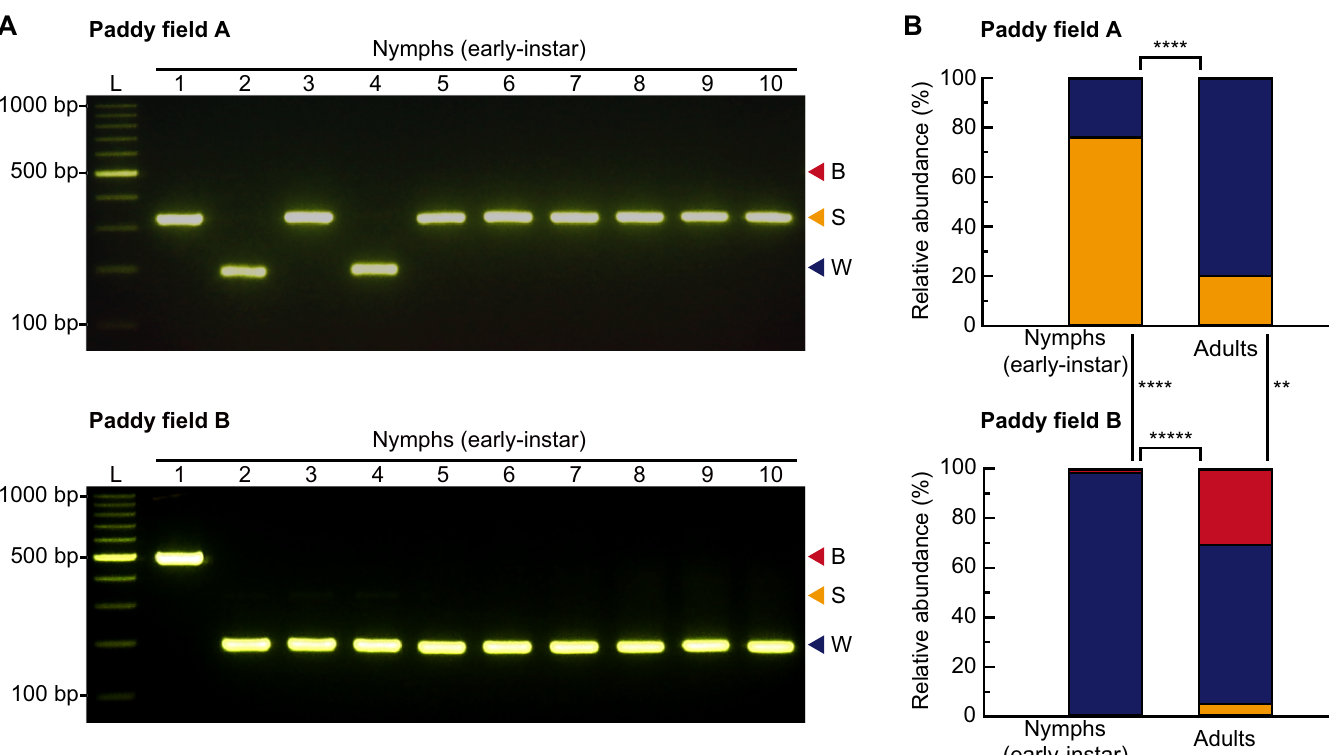
Fig 3. Quantification of rice planthopper species in paddy fields approximately one month after rice-planting. (A) Example gel electrophoresis results of multiplex PCR assays of individual early-instar nymphs from paddy fields A (top) and B (bottom). L, 100 bp DNA ladder; B, Nilaparvata lugens ; S, Laodelphax striatellus ; W, Sogatella furcifera . (B) Species composition of early-instar nymph and adult rice planthoppers ( N . lugens [red bars], S . furcifera [blue bars], and L . striatellus [yellow bars]) in paddy fields A (early-instar nymphs, n = 54; adults, n = 20) (top) and B (early-instar nymphs, n = 107; adults, n = 39) (bottom). �� , P < 0.01; ���� , P < 0.0001; ����� , P < 0.00001 (chi-squared